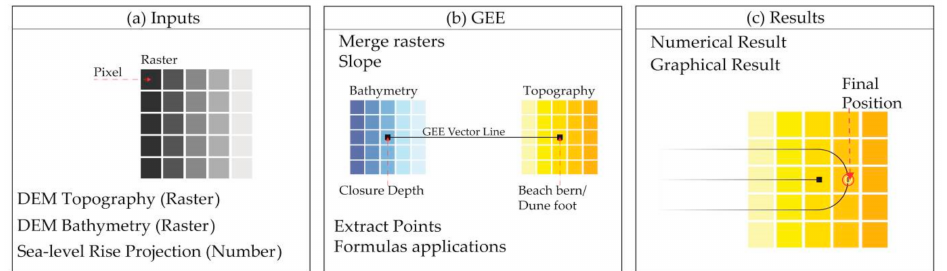
Figure 3. ( a ) Model inputs: DEM of topography and DEM of bathymetry, both in raster format, and the value number of sea-level rise projection. ( b ) Google Earth Engine: the rasters are merged and to calculate the slope. The depth of closure and beach berm values are extracted directly from GEE. ( c ) Numerical and graphical result, in the last case symbolized by a